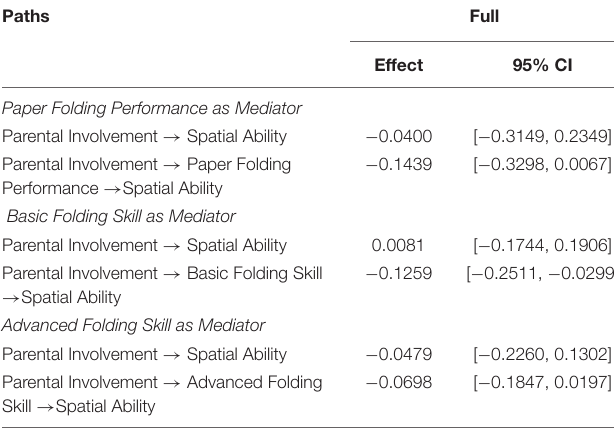
TABLE 6 | Direct and indirect effects of parental involvement on spatial ability in early